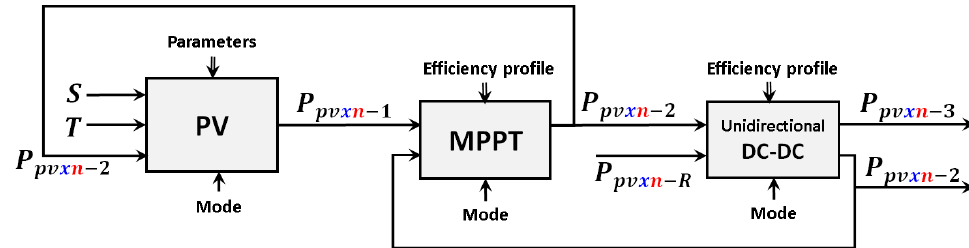
Figure 2. Block diagram of the programmed model of PVG.